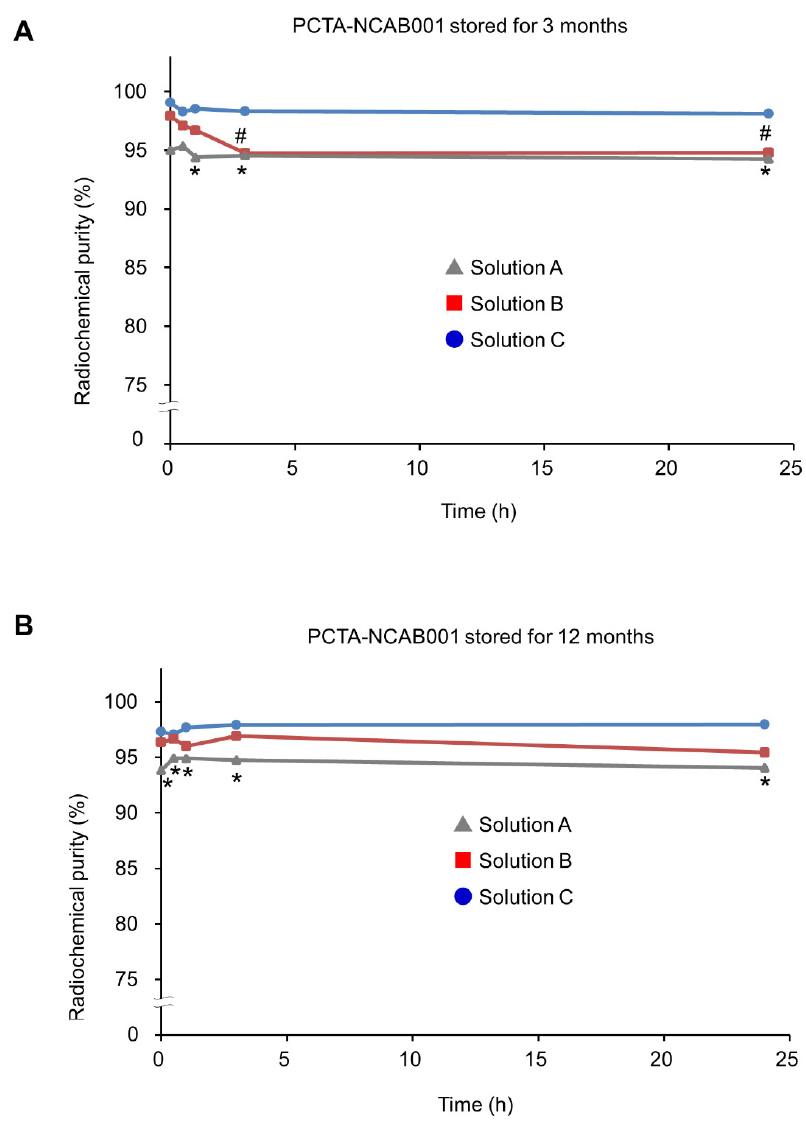
Figure 5. Effect of the stock solutions on the stability of 64 Cu-NCAB001. We prepared radiolabeled 64 Cu-NCAB001 using PCTA-NCAB001 stored at 4 ◦ C for 3 months ( A ) and 12 months ( B ) in Solutions A, B, and C (composition in Table 1) and compared the radiochemical purity of each preparation; * and # denote a radiochemical purity less than 95%.